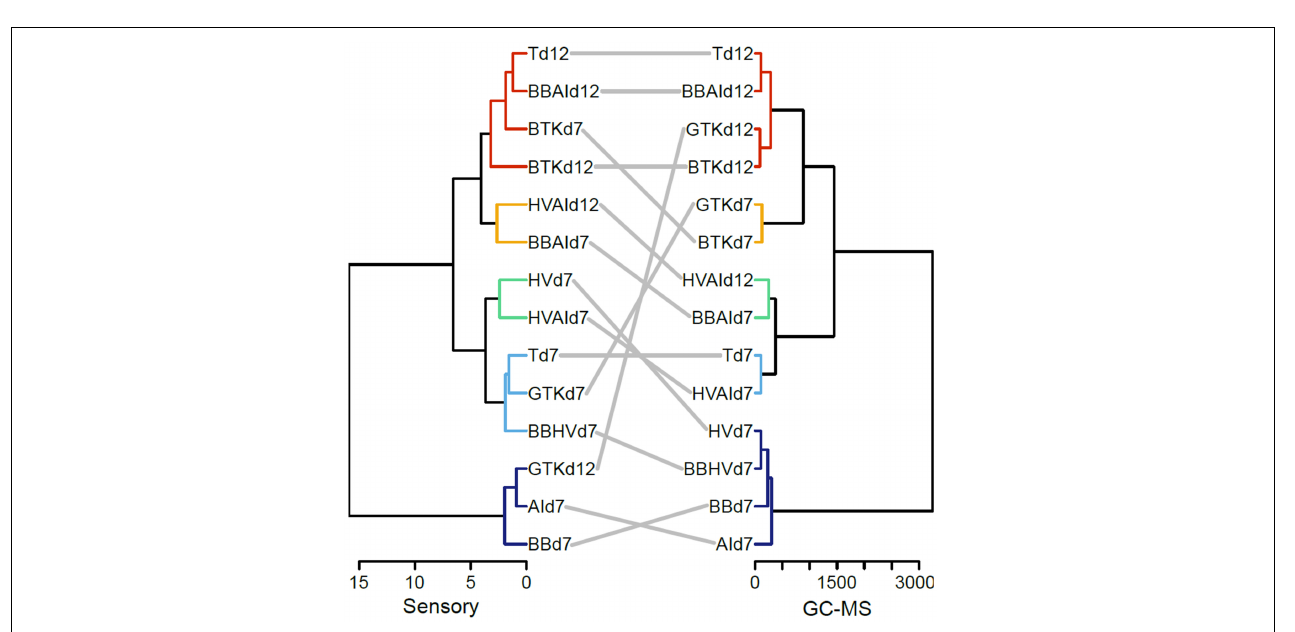
FIGURE 3 | Heatmap depicting pair-wise Spearman correlations (R; p < 0.05: *) between a sensory descriptor score and a single metabolite numbered as in the Table 2 and colored consistently as its chemical family.